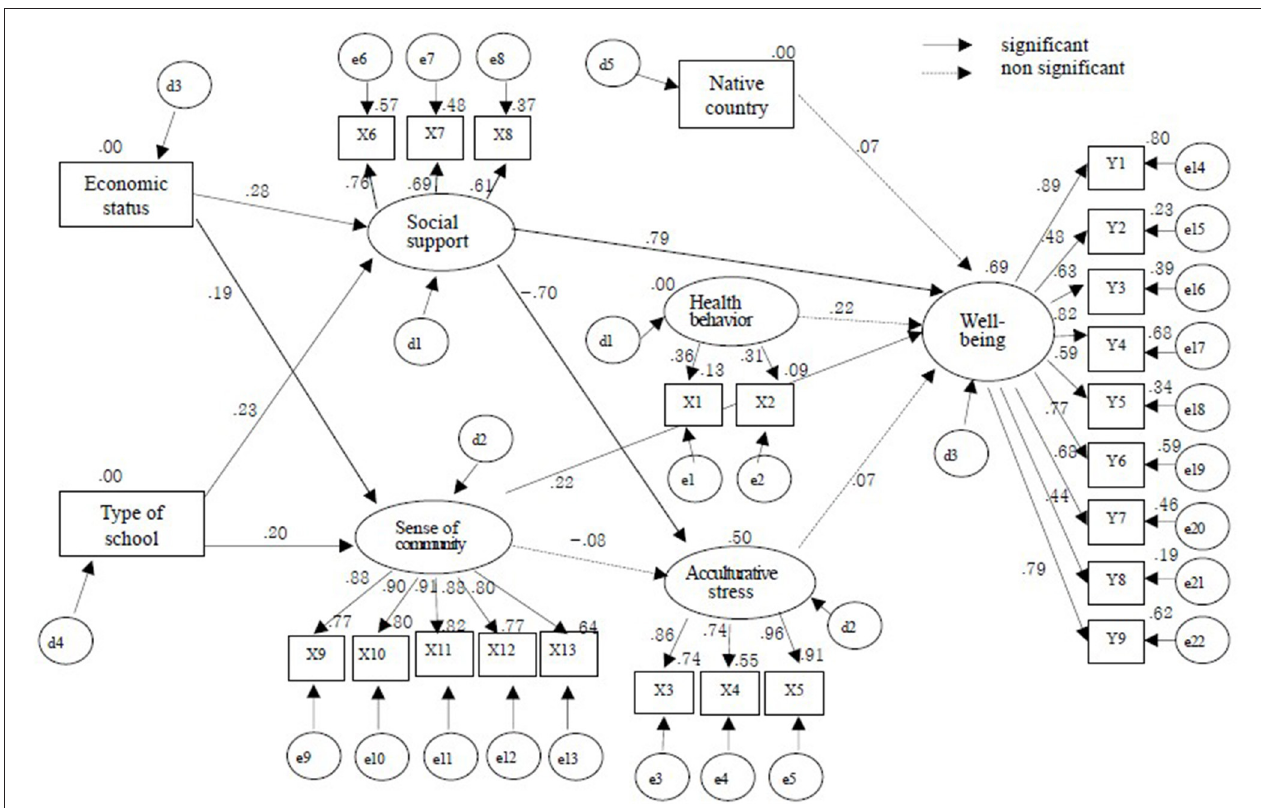
FIGURE 2 | Structural equation model.